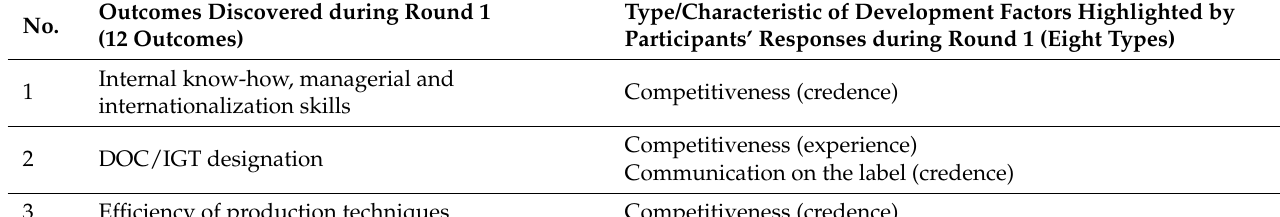
Table 3. Respondents’ association of outcomes with development factors which emerged during round